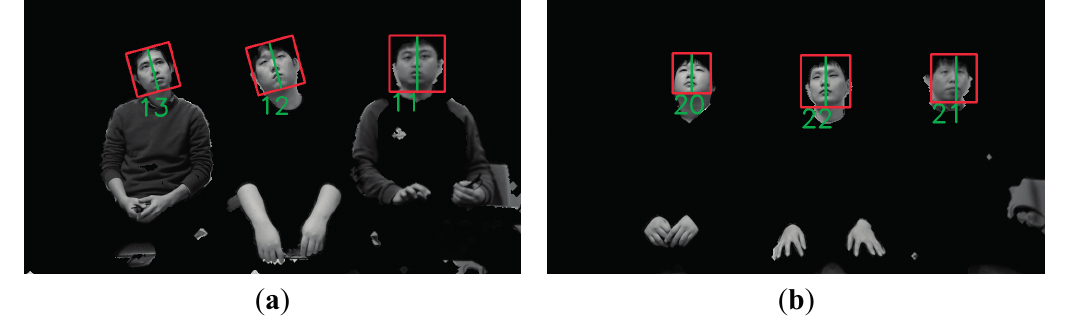
Figure 17. Examples of the success of face